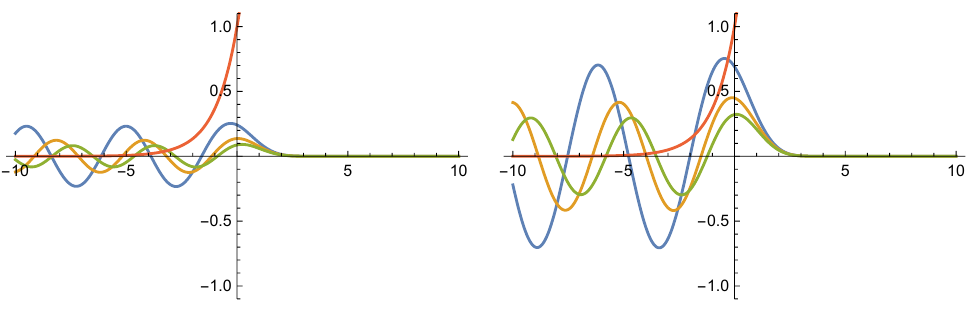
p 1 : 5 (right) and (cid:12)xed